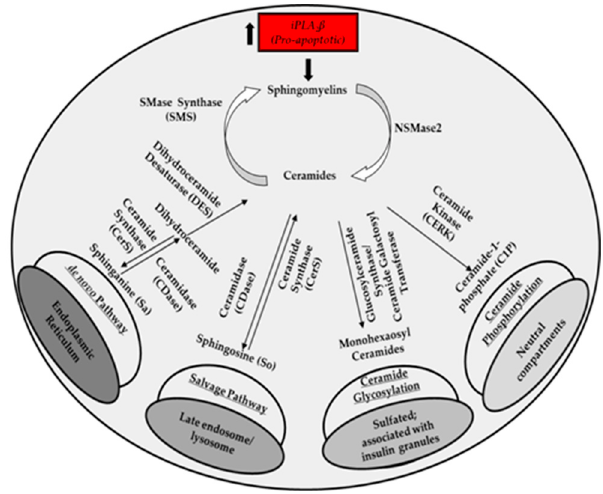
Figure 7 . Proposed model of the impact of iPLA 2 β activation of β -cell sphingolipids. Ceramides are the central species, and arrows in brackets indicate changes to the specific lipid-derived species in conditions that increase iPLA 2 β and in turn favor pro-apoptotic outcomes.